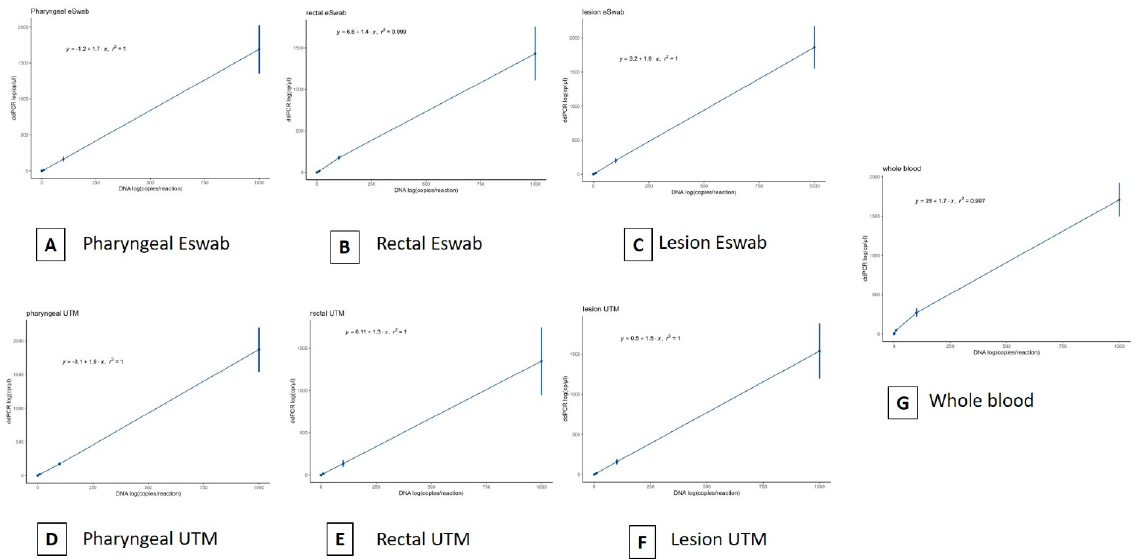
Figure 2. Evaluation of the ddPCR assay performance using MPXV synthetic amplicons and Gblock sequences as reference DNA. Standard curves were obtained from 10-fold serial dilutions of the reference DNA (3.5 × 10 4 copies/ µ L) in four biological matrices in two different transport media (UTM and eSwab). The curves also include the negative point (no DNA). ( A – G ). The error bar represented the standard deviation of the mean. Pearson statistics were used.